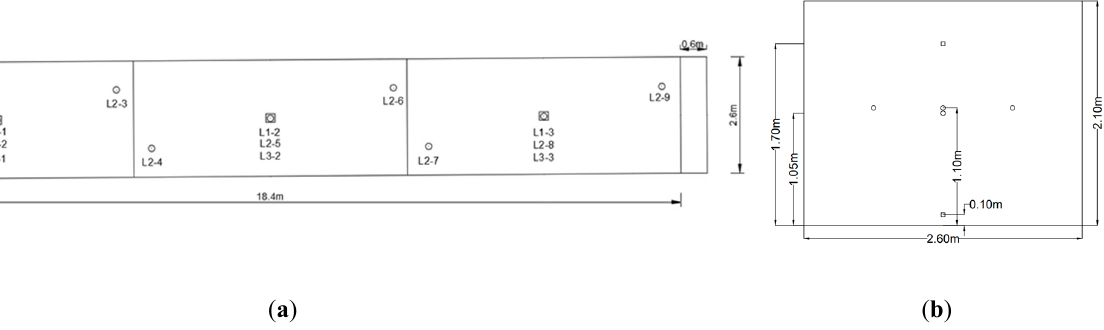
Figure 8. The arrangement of measuring points in the passenger compartment, shown in the top view ( a ) and the left view ( b ).